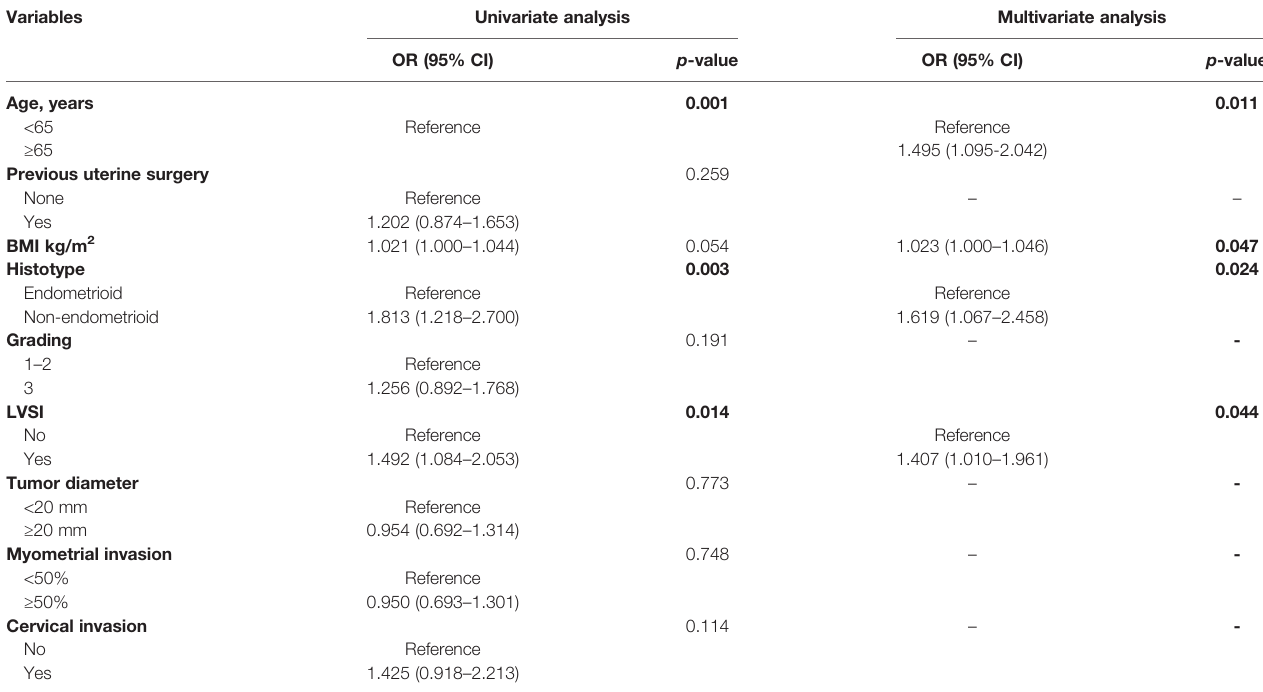
TABLE 4 | Uni- and multivariate analysis for SLN mapping failure.